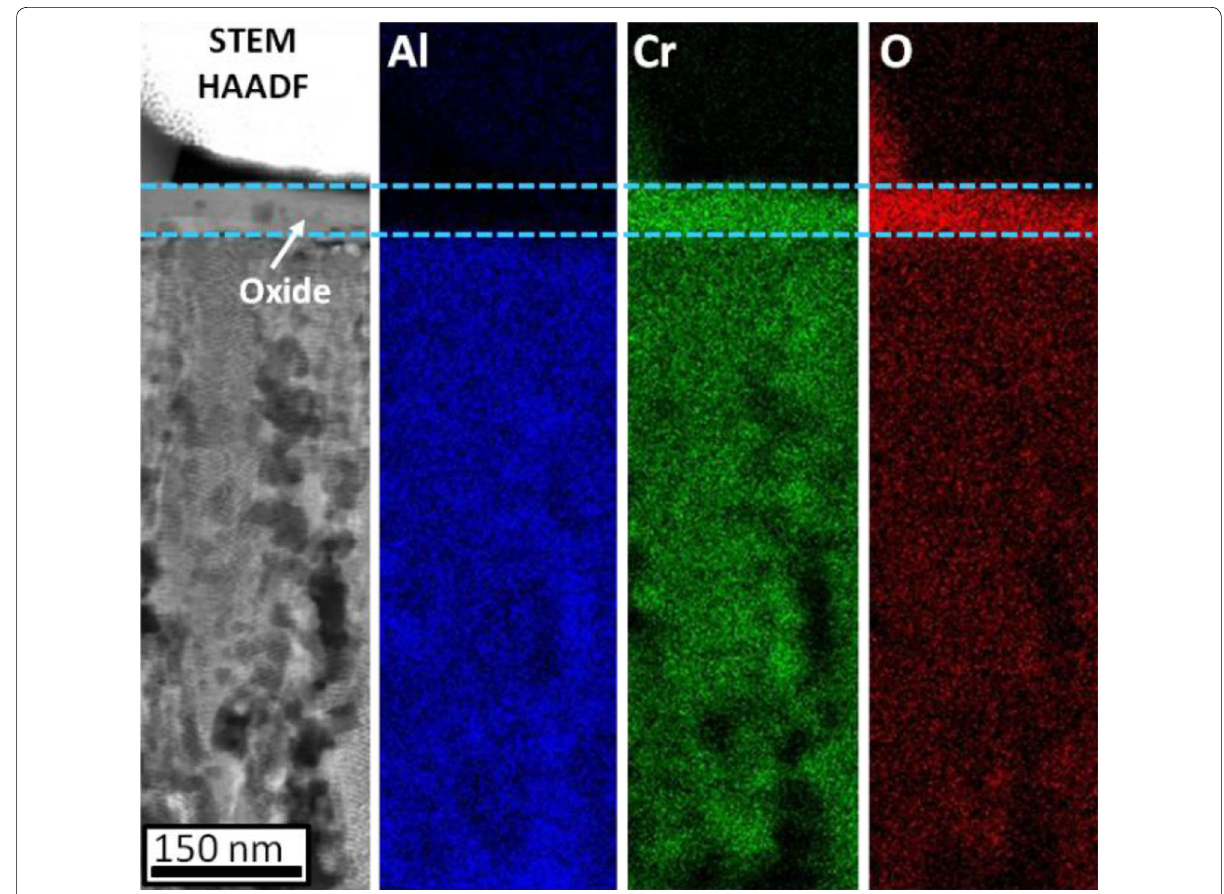
Fig. 4 STEM HAADF and EDS mappings of the c‑AlN/CrN superlattice annealed for 60 min at 900